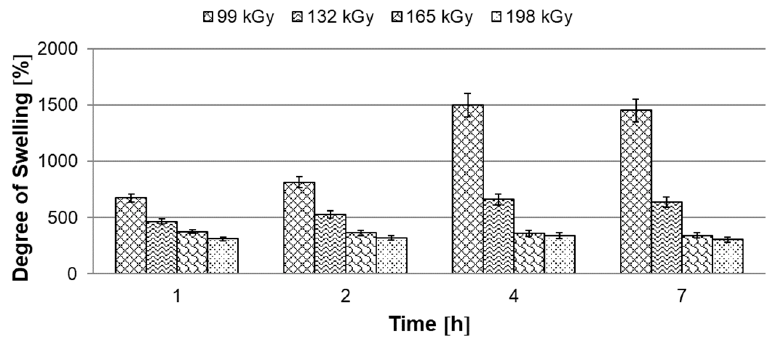
Figure 5. Dependence of swelling degree on time.